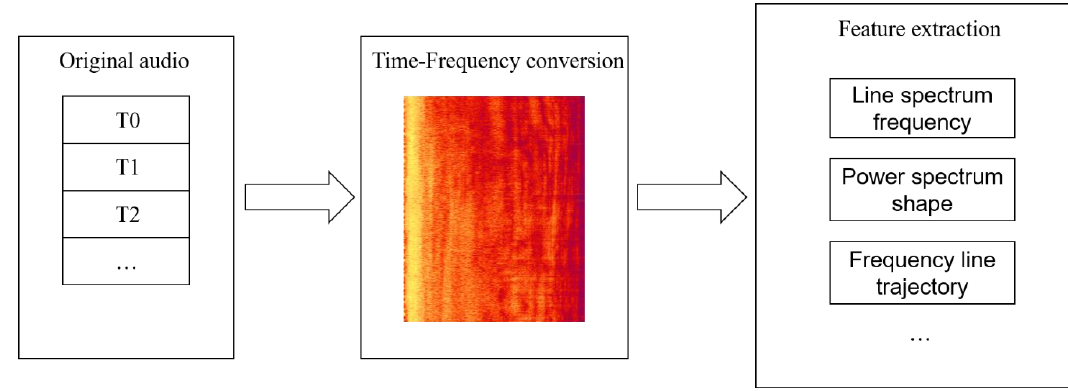
Figure 3. Schematic diagram of the LOFAR method.